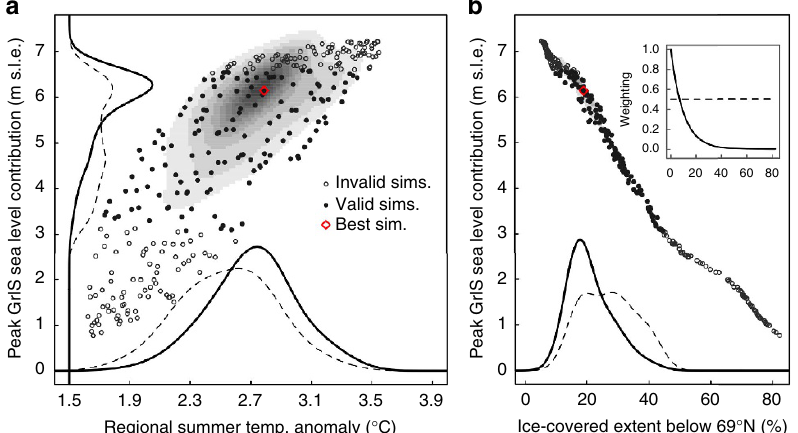
Figure 2 | MIS-11 peak estimates. Posterior probability distributions for the maximum Greenland ice sheet contribution to sea level versus the maximum regional summer temperature anomaly ( a ) and the minimum ice cover south of 69 (cid:2) N ( b ). Invalid (open circles) and valid (solid circles) simulations are shown, as well as the most likely simulation (red diamond). The shading represents the 2D probability density estimate which combines the prior ensemble with the posterior weighting as described in the text, while the lines show the 1D equivalent. The exponential weighting function (solid line in the inset) was used by default, while uniform weighting was also tested (dashed lines), giving similar locations of the probability density maxima. NATURE COMMUNICATIONS|8:16008|DOI: